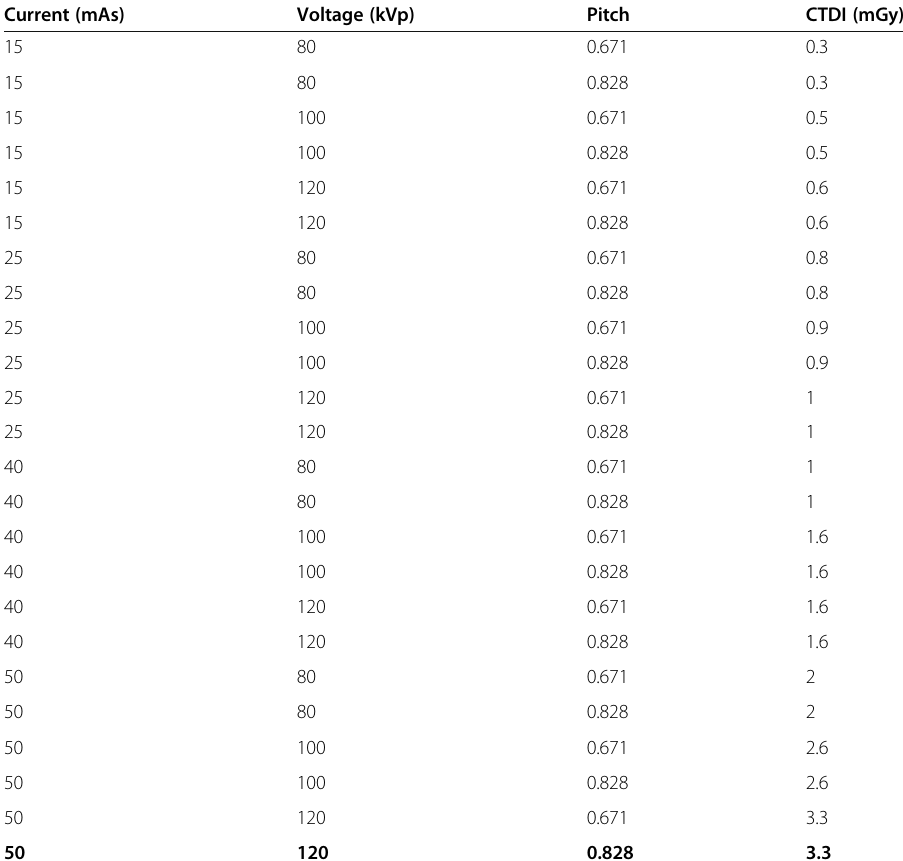
Table 1 CT acquisition parameter combinations used (reference CT reconstruction shown in bold) Current (mAs) Voltage (kVp) Pitch CTDI